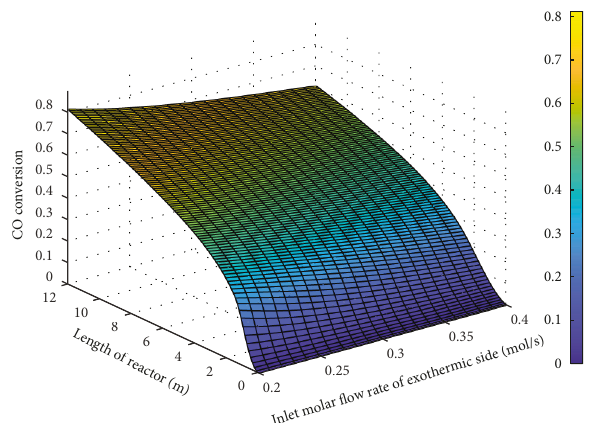
Figure 10: Effect of molar flow rate in the exothermic part on the CO conversion rate and MEK